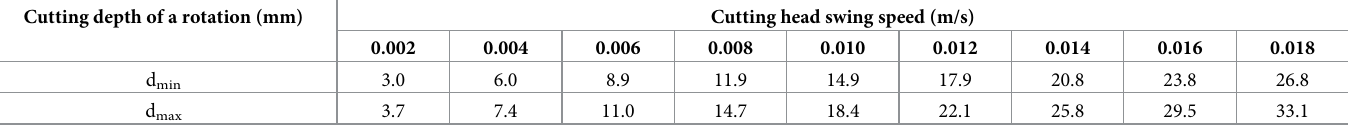
Table 4. Cutting depth with various cutting head moving